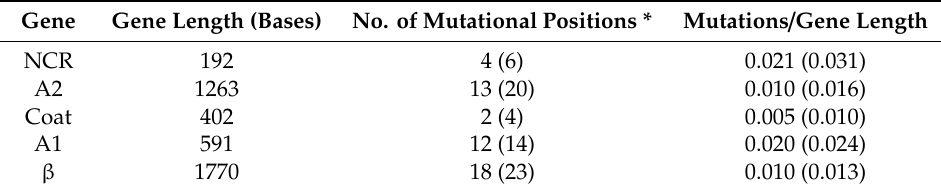
Table 3. Tendency of mutations within individual Q β